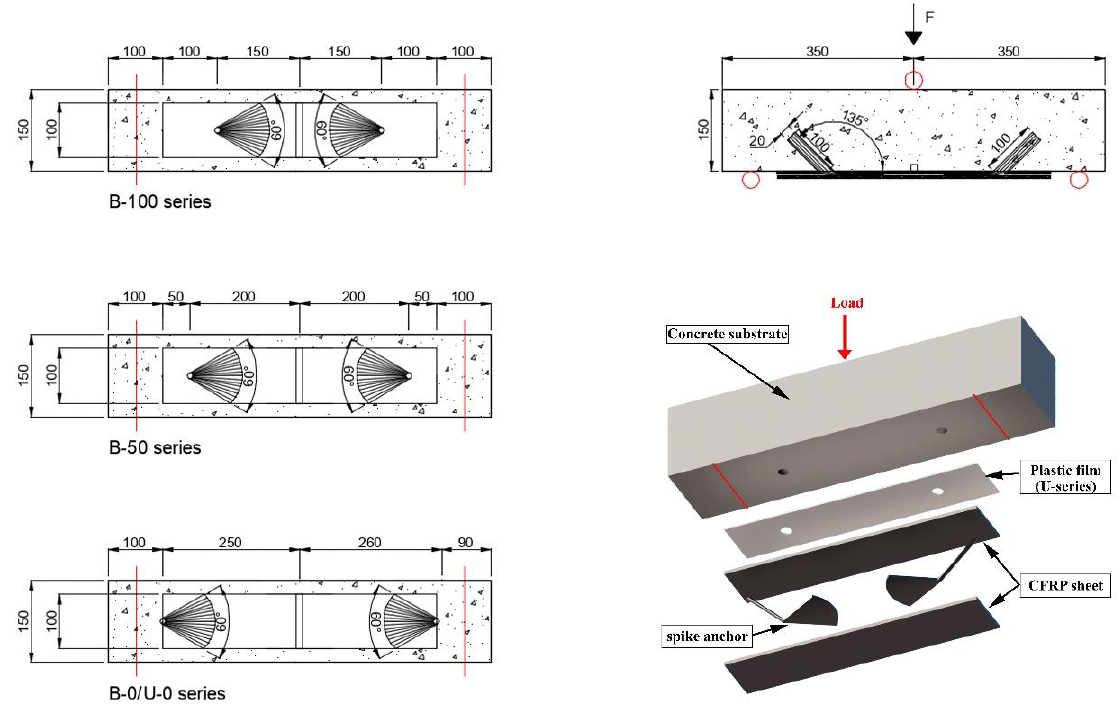
Figure 3. Specimen configuration.